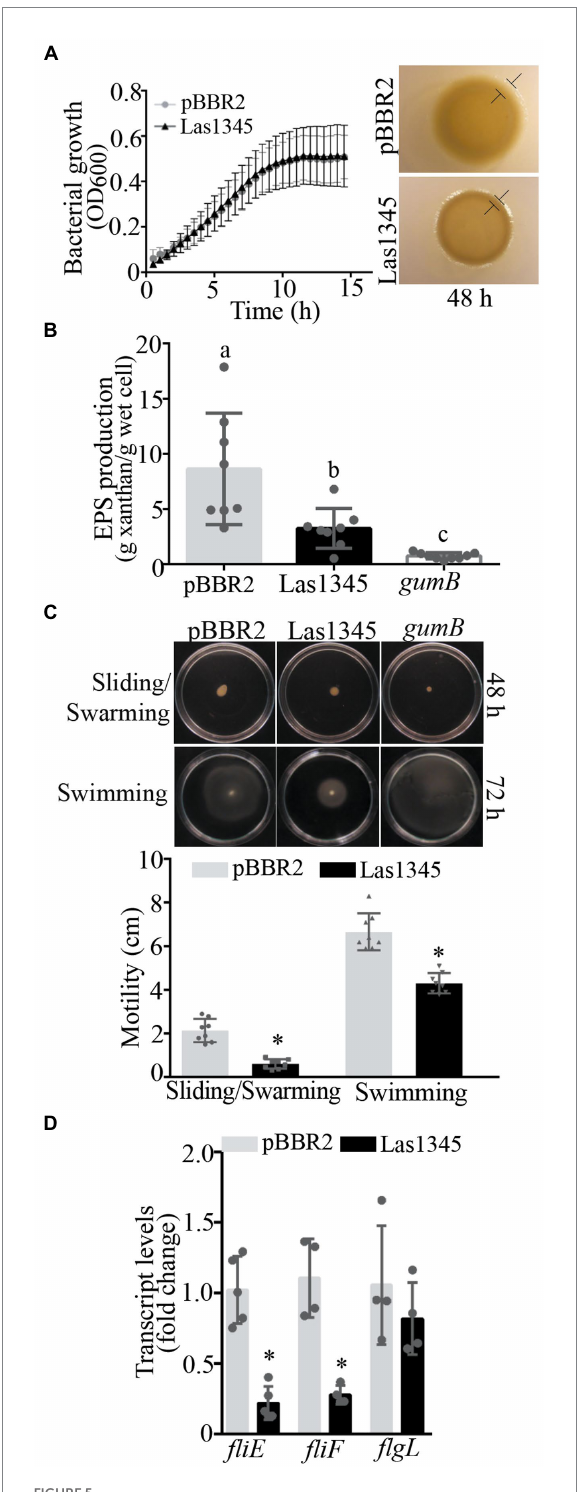
FIGURE 5 Las1345 expression reduce xanthan production and cell motility . (A) , Xanthomonas campestris pv . campestris ( Xcc ) growth in NYGB medium. Values are expressed as means ±